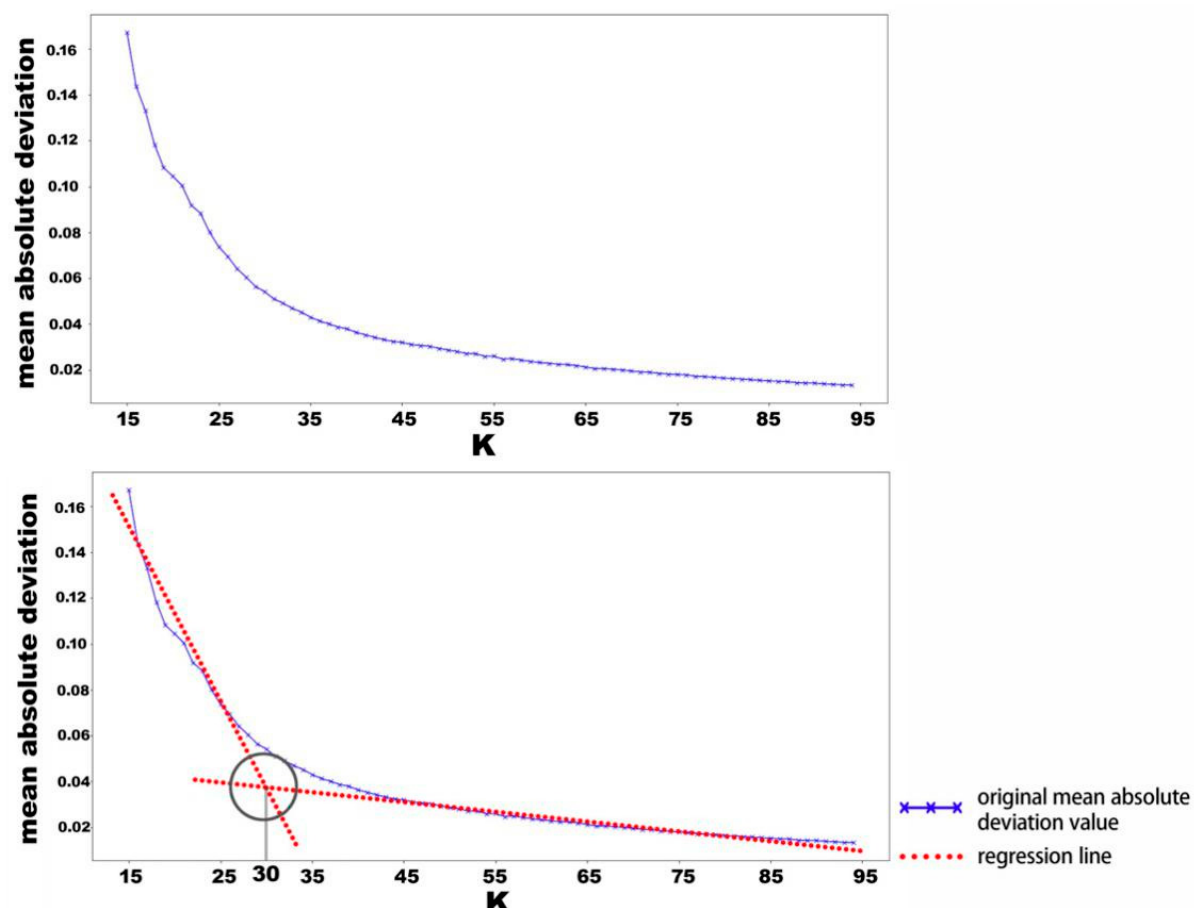
Figure 9. Selection of the K value using the elbow method.